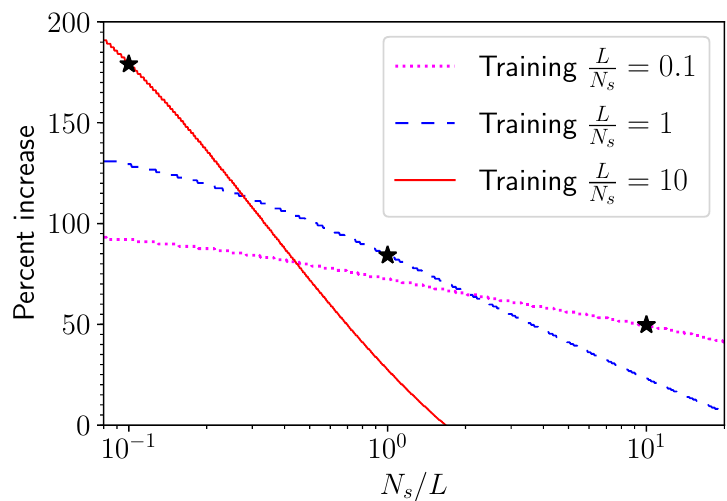
/ L , if using I MC / L . Each (cid:198) mark corresponds to the s